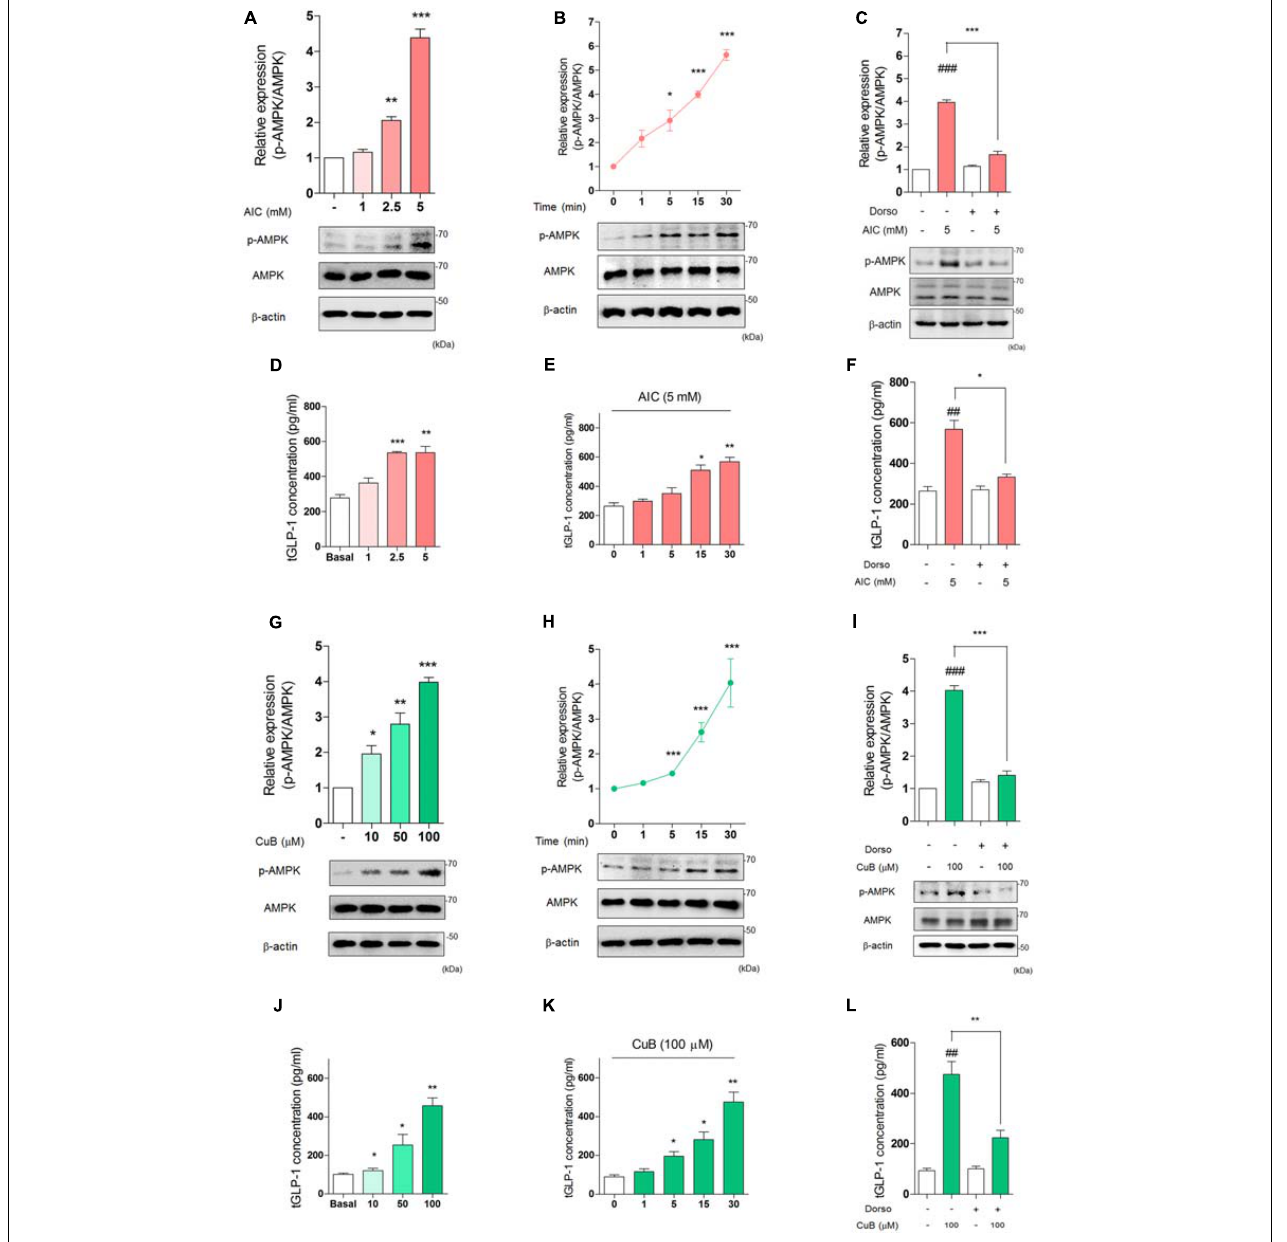
FIGURE 3 | Activation of AMPK stimulates GLP-1 secretion in differentiated NCI-H716 cells. (A) AIC treatment dose-dependently induced activation of AMPK in differentiated NCI-H716 cells. (B) AIC (5 µµ ol/l) treatment time-dependently increased activation of AMPK during 30 min. The densitometry of AMPK ratio was represented in the graph. Data are presented as a Mean ± SEM, n = 6. ∗ P < 0.05, ∗∗ P < 0.01, ∗∗∗ P < 0.001 vs. control. (C) After treatment with Dorso (5 µ M) for 30 min, AIC-induced activation of AMPK was inhibited. Data are presented as a Mean ± SEM, n = 3. ### P < 0.001 vs. control, ∗∗ P < 0.05 vs. Dorso + AIC. (D) AIC treatment dose-dependently induced GLP-1 secretion from 1 mM to 5 mM in differentiated NCI-H716 for 30 min. (E) AIC (5 mM) treatment time-dependently induced GLP-1 secretion for 30 min. Data are presented as a Mean ± SEM, n = 8. ∗ P < 0.05, ∗∗ P < 0.01, ∗∗∗ P < 0.001 vs. control. (F) After treatment with Dorso, AIC-induced GLP-1 secretion was inhibited. Data are presented as a Mean ± SEM, n = 3. ## P < 0.01 vs. control, ∗ P < 0.05 vs. Dorso + AIC. (G) CuB dose-dependently activated AMPK expression levels from 10 µ M to 100 µ M in differentiated NCI-H716 cells. (H) CuB (100 µ M) treatment time-dependently increased activation of AMPK during 30 min. The densitometry of AMPK ratio was represented in the graph. Data are presented as a Mean ± SEM, n = 6. ∗ P < 0.05, ∗∗ P < 0.01, ∗∗∗ P < 0.001 vs. control. (I) After treatment with Dorso for 30 min, CuB-induced activation of AMPK was inhibited. Data are presented as a Mean ± SEM, n = 3. ### P < 0.001 vs. control, ∗∗∗ P < 0.001 vs. Dorso + CuB. (J) CuB treatment dose-dependently stimulated GLP-1 secretion from 10 µ M to 100 µ M in differentiated NCI-H716 for 30 min. (K) CuB (100 µ M) treatment time-dependently stimulated GLP-1 secretion for 30 min. Data are presented as a Mean ± SEM, n = 8. ∗ P < 0.05, ∗∗ P < 0.01, ∗∗∗ P < 0.001 vs. control. (L) After treatment with dorsomorphin, CuB-mediated GLP-1 secretion was inhibited. Data are presented as a Mean ± SEM, n = 3. ## P < 0.01 vs. control, ∗∗ P < 0.01 vs. Dorso + CuB. AIC, 5-Aminoimidazole-4-carboxamide-1- β - D -ribofuranoside. Dorso, Dorsomorphin. CuB, Cucurbitacin